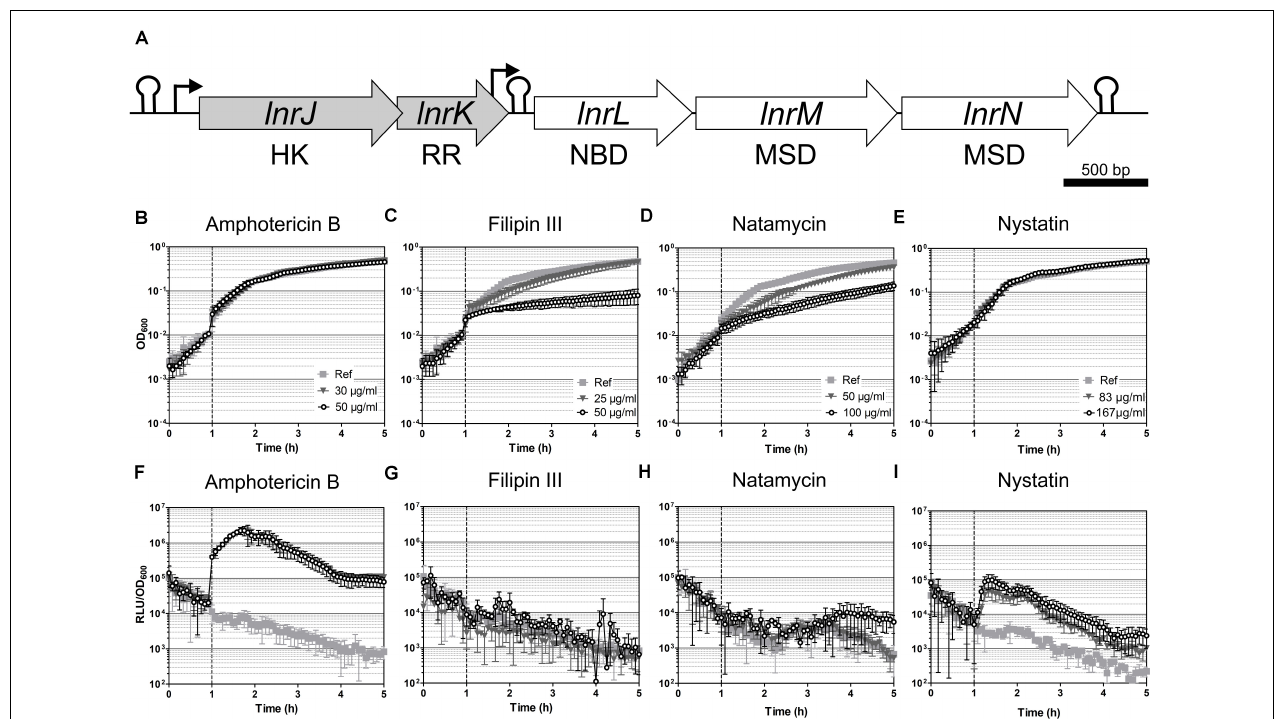
FIGURE 3 | Induction spectrum of the LnrJKLMN system in B. subtilis . (A) Genetic organization of the lnrJKLMN operon (formerly known as yfiJKLMN ) (Yamamoto et al., 1996). The genes lnrJ and lnrK (block gray arrows) encode for a two-component system; the genes lnrL , lnrM and lnrN (block white arrows) encode for an ABC transporter. Genes drawn to scale. Rho-independent transcriptional terminators are indicated by hairpins; promoters are indicated by black bent arrows; HK, histidine kinase; RR, response regulator; NBD, nucleotide binding domain; MSD, membrane spanning domain. (B–I) Induction of the P lnrL 468 promoter by macrolide polyenes in liquid media. Effect of antibiotic exposure on growth is indicated as OD 600 (B–E) , and promoter induction as relative luminescence units by OD 600 (F–I) . The time of antibiotic addition is indicated with a vertical dashed line. The antibiotic concentrations used are indicated in the upper panel graphs. The results presented from (B) to (I) correspond to strain TMB4220. The experiments were performed at least in triplicate with two independent clones. Means and standard deviations are